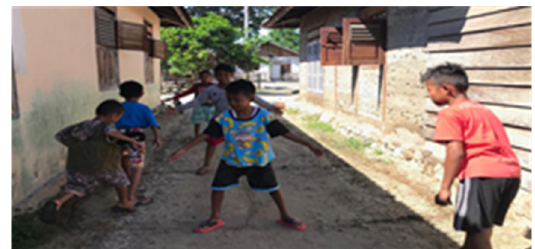
Figure 3. Aseng molega. Figure 3. Aseng